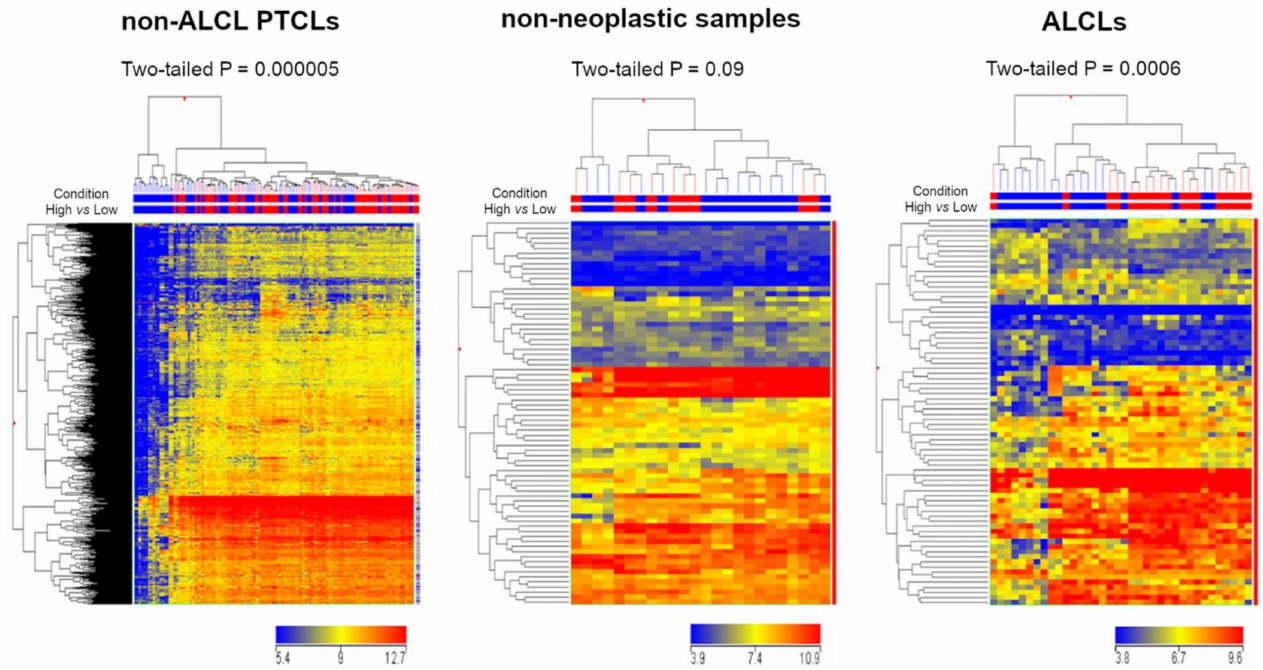
Figure 6. SELPLG gene expression correlates with TCR signaling. TCR: No significant enrichment at Gene Set Enrichment Analysis (GSEA), but correlation at clustering. Red: high expression; blue: low